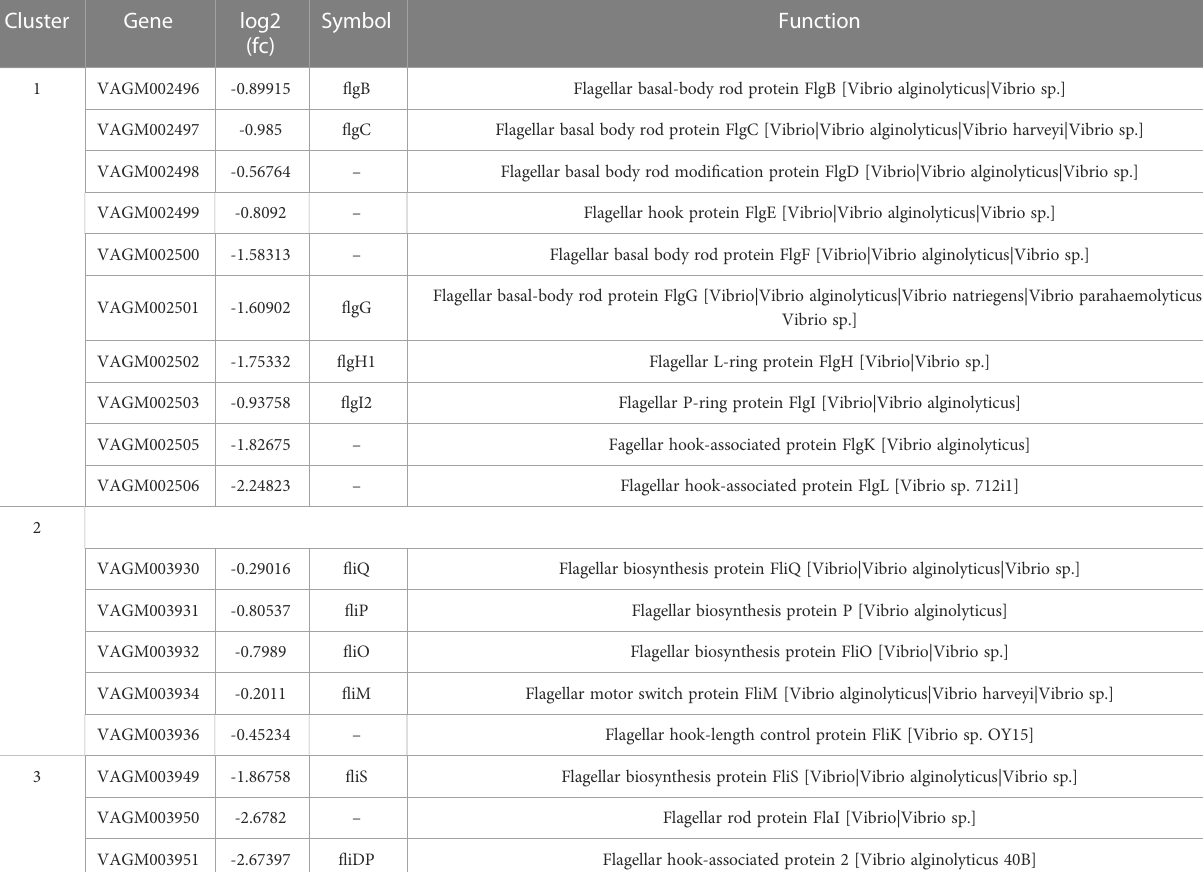
TABLE 4 Motility-related genes were down-regulated (>1.5-fold change) in the mutant strains. Cluster Gene log2 (fc)